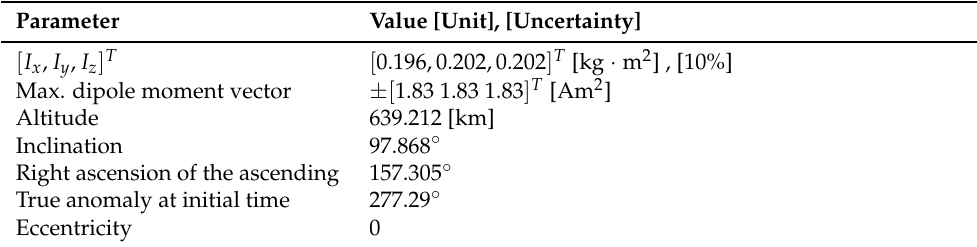
Table 1. Spacecraft and orbital parameters.